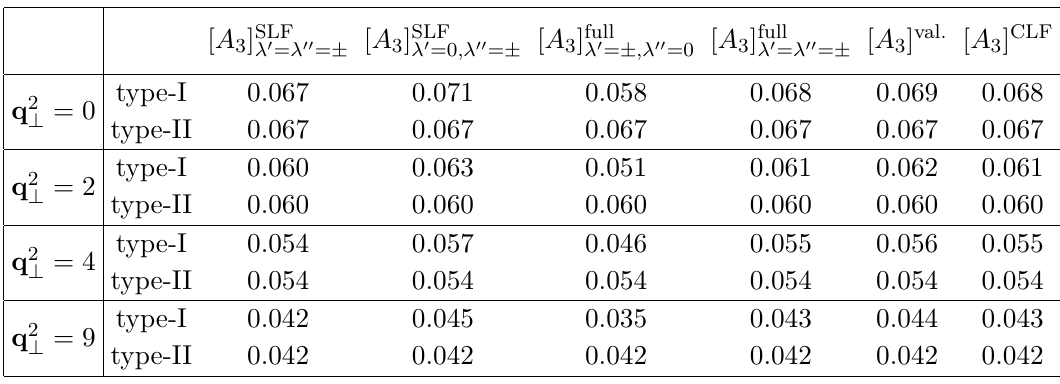
) at q 2 = (0 ; 2 ; 4 ; 9) GeV 2 for B (cid:3) ! D (cid:3) transition. ? ?